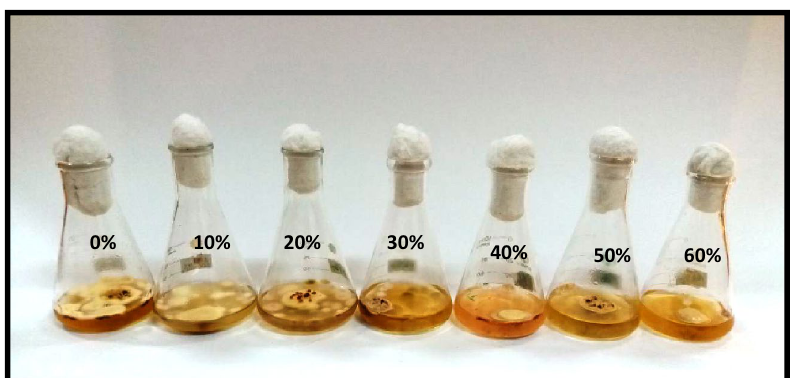
Figure 5. Effect of metabolite concentrations of P. verrucosum on the growth of P. herbarum.